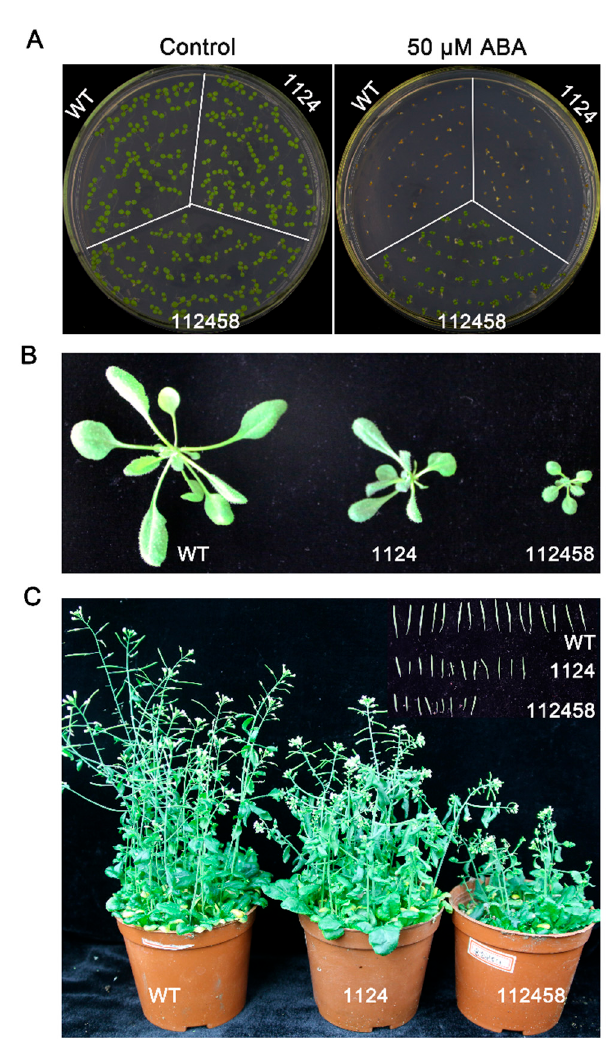
Figure 1. Combined loss of function of RCAR genes impairs plant growth. ( A ) Photographs of Col wild-type, 1124 and 112458 plants grown for 7 days on MS medium either lacking or supplemented with 50 µ M ABA. ( B , C ) Photographs show the impairment of growth and reproduction in ABA receptors mutants. Photographs of 20-d-old plants ( B ), 40-d-old plants and siliques ( C ) grown under greenhouse conditions of Col wild-type, 1124 and 112458.